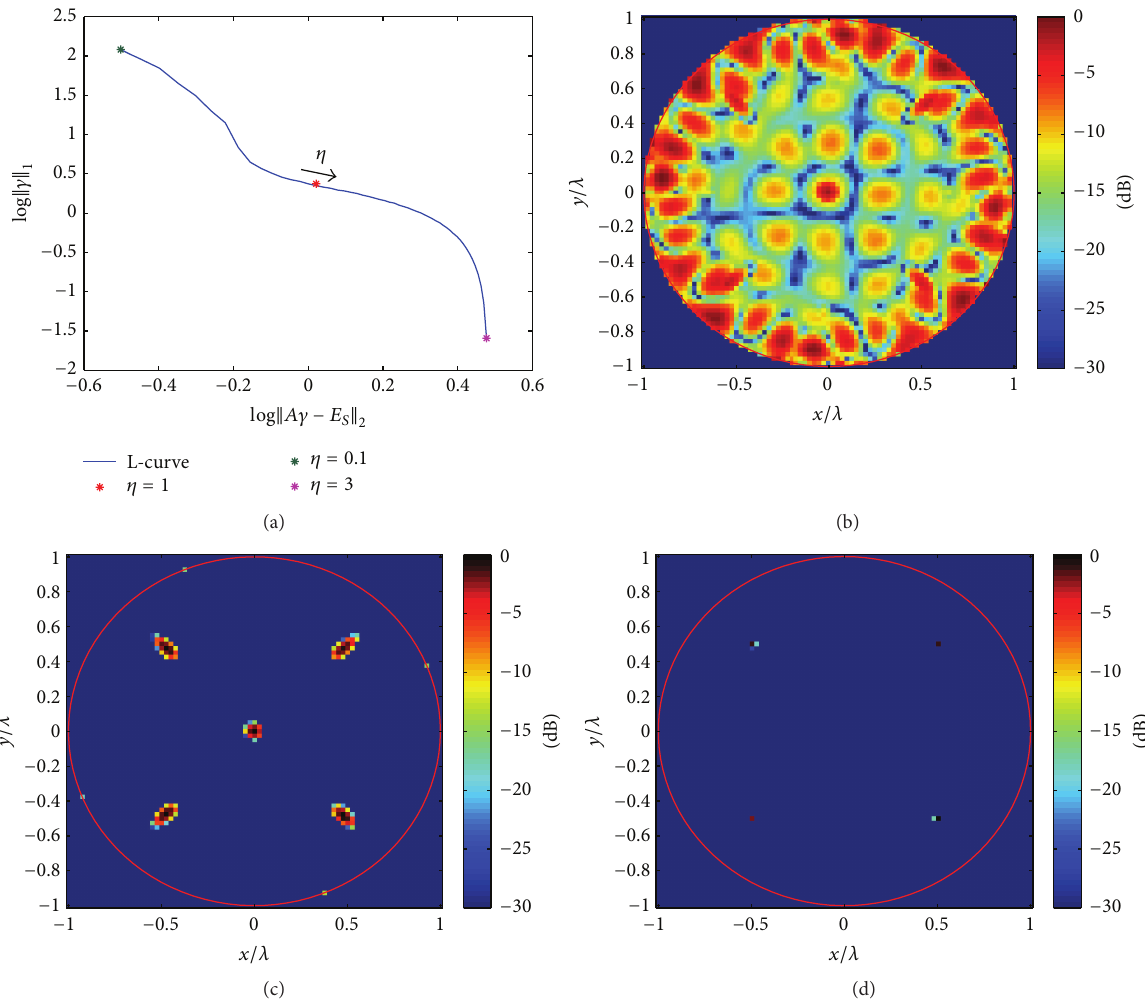
Figure 7: (a) L-curve using BPDN criterion, (b) reconstruction with 𝜂 = 0.1 , (c) reconstruction with 𝜂 = 1 , and (d) reconstruction with 𝜂 = 3 .